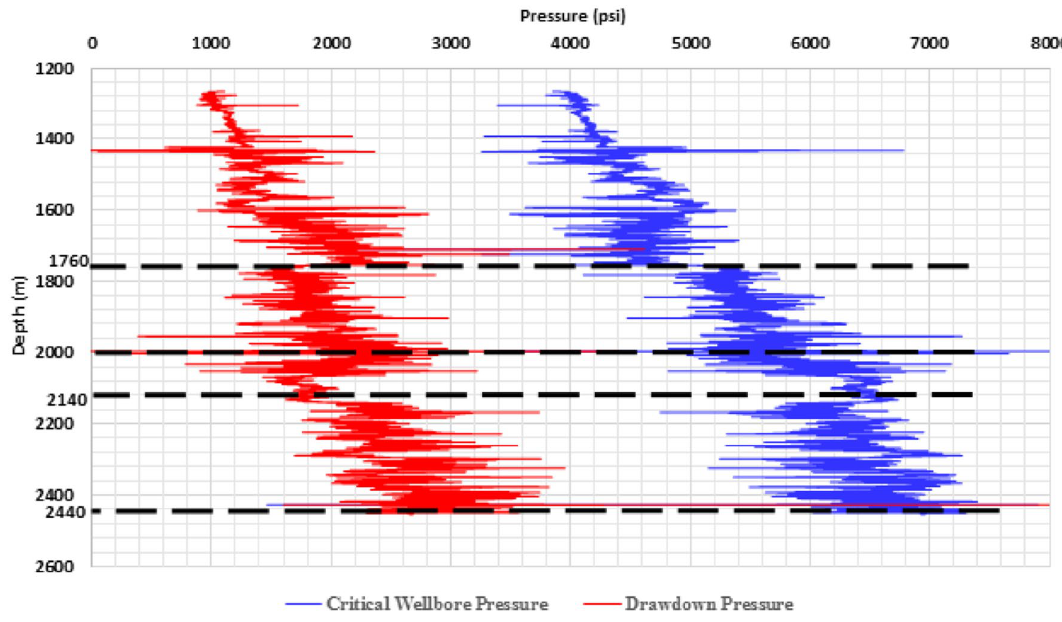
Fig. 24 Critical wellbore pressure and drawdown pressure of Field Y Fig. 25 Geomechanical model validation of Field